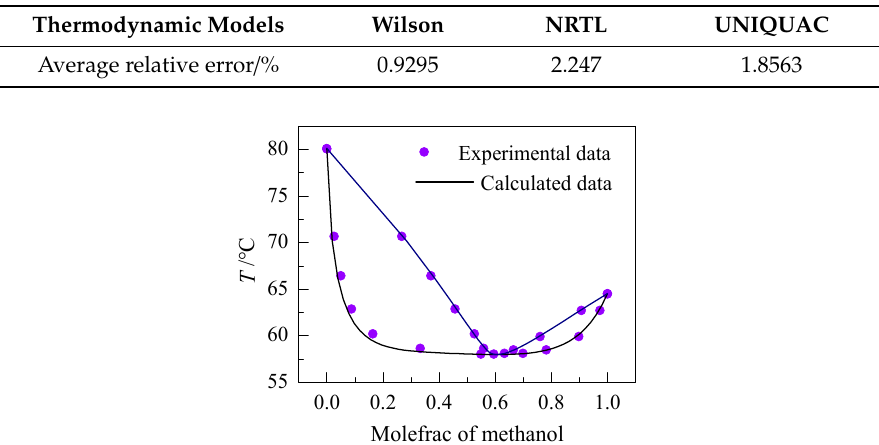
Table 1. The error analysis of the thermodynamic models.